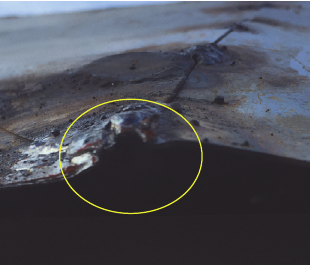
Figure 13: First explosion venting position in experimental